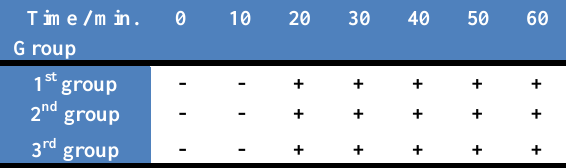
Table, 4: shows Eye reflex in all the three